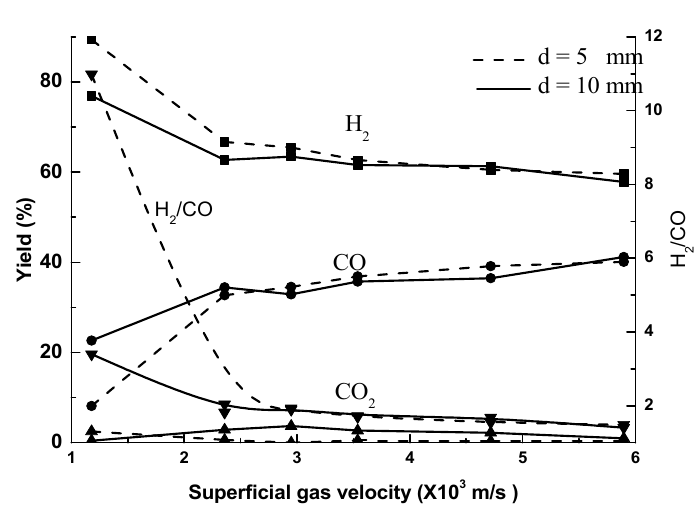
Figure 4. Syngas composition as a function of gas the velocity (temperature: 400 ◦ C, plate position: 15